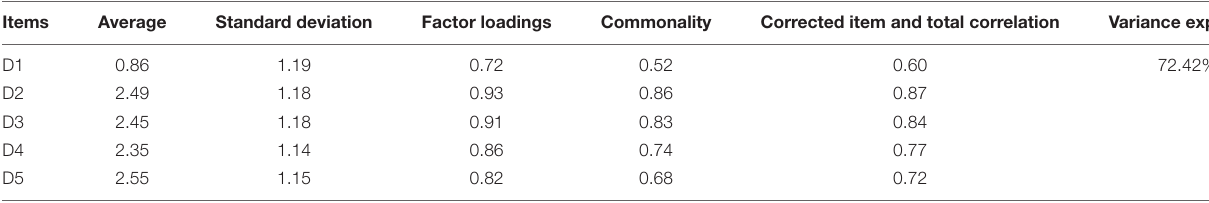
TABLE 3 | Summary of factor analysis on academic performance.